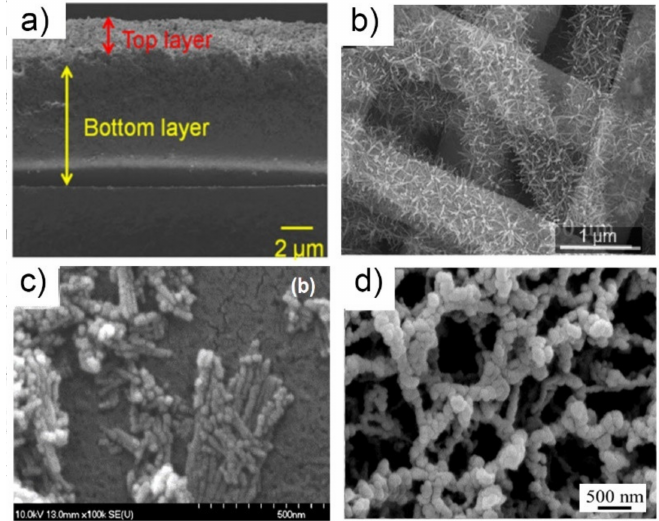
Figure 1. SEM images of PMs prepared by ( a ) dip-coating [65]; ( b )